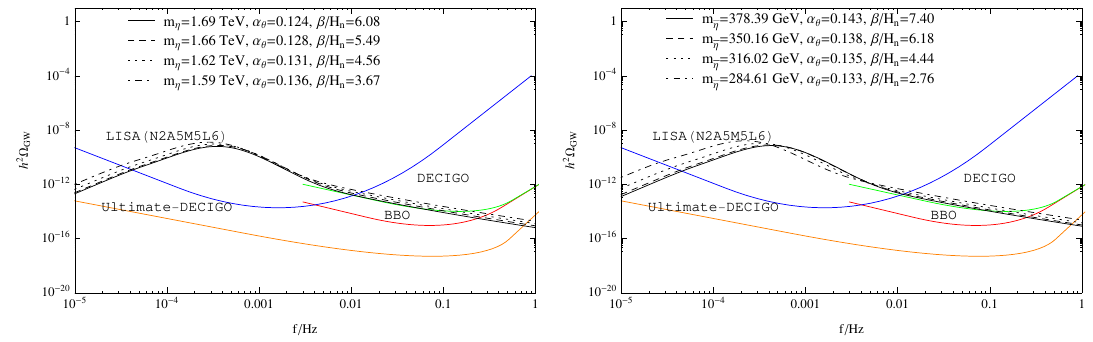
Figure 8 . The contributions of GW spectrum vary with parameters m η and m